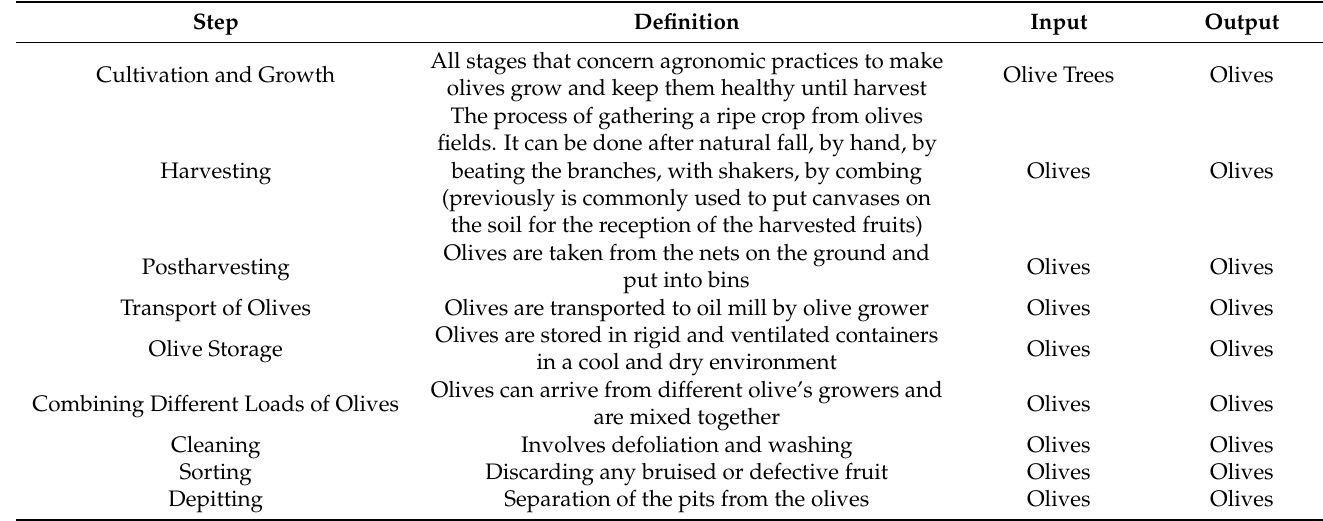
Figure 3. Flowchart of the edible virgin olive oils supply chain. Table 1. Extract of the table describing each step with their inputs and outputs .